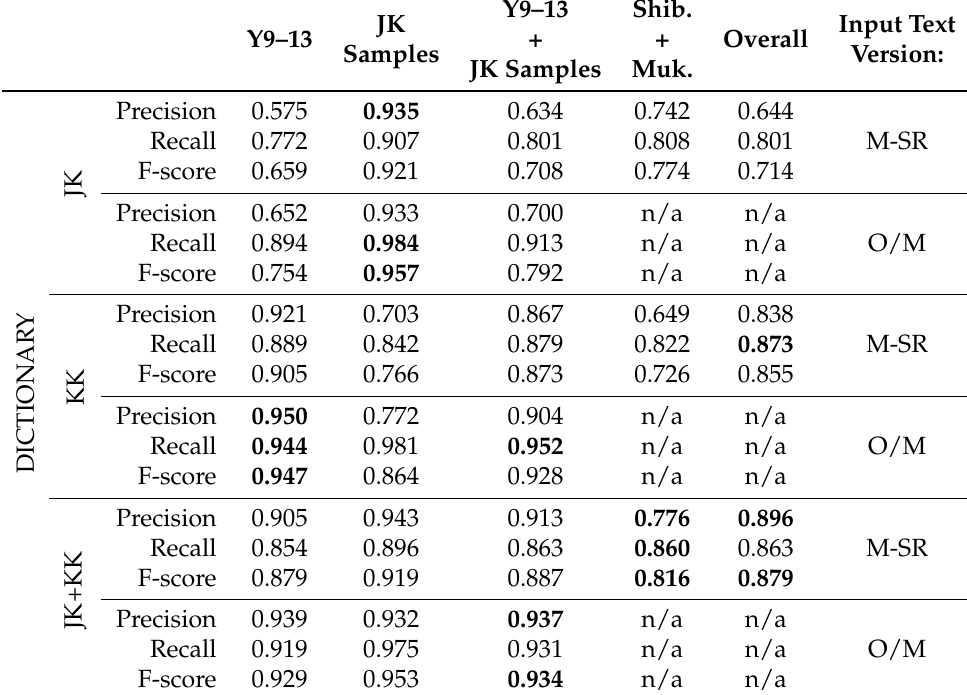
Table 12. Tokenization experiment results (best results in